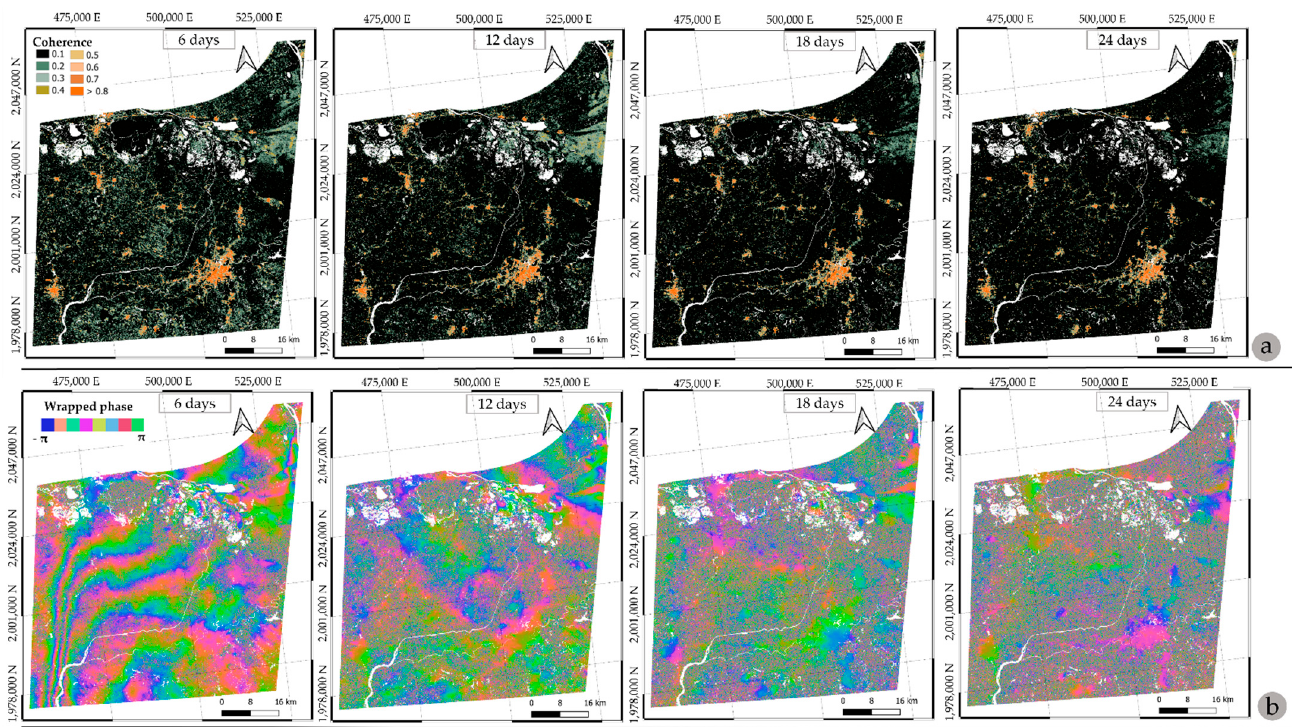
Figure 5. ( a ) Coherence and ( b ) wrapped differential interferograms for selected Sentinel-1 SLC image pairs (Table 3).